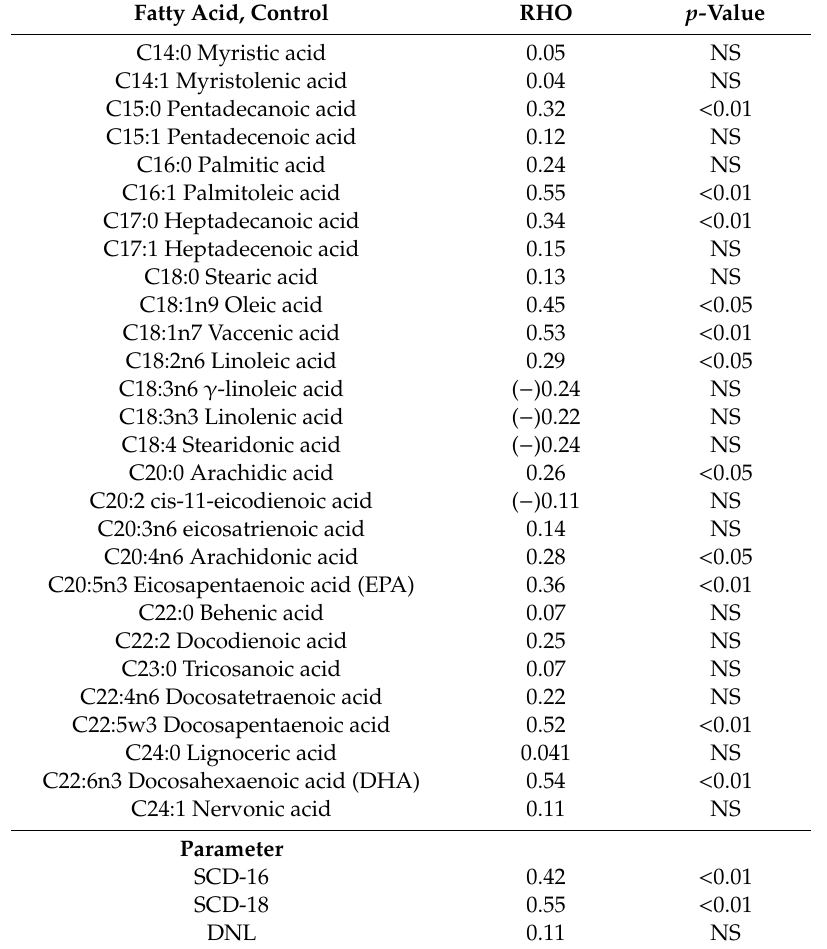
Table 2. Correlation of fatty acids between liver and blood cells in the control